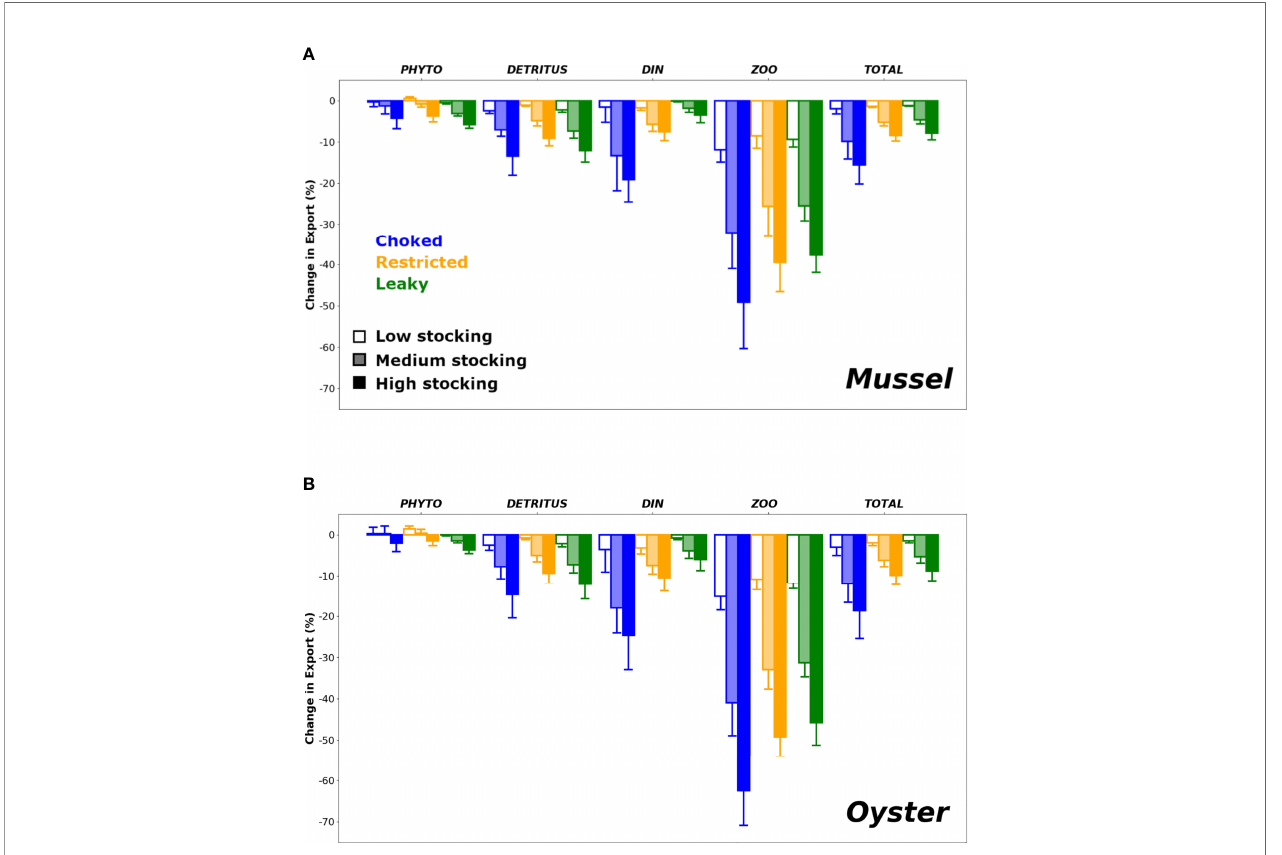
FIGURE 4 | Mean (±SD) relative change in the net export of the different pelagic variables (PHYTO: phytoplankton, DETRITUS: detritus, DIN: dissolved inorganic nitrogen, ZOO: zooplankton and TOTAL: total nitrogen, i.e. all variables combined) to the coastal ocean following the introduction of (A) mussel or (B) oyster farms and as a function of stocking surface area and bay morphology. Error bars represent variability introduced by other factors (i.e. nutrient loading and